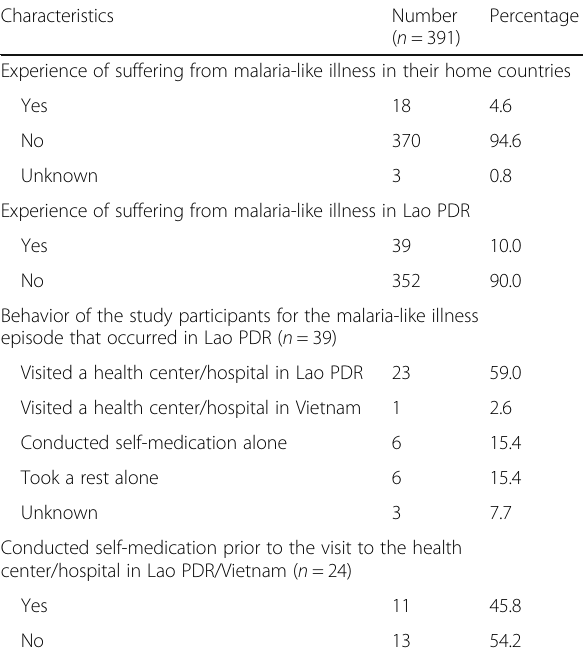
Table 3 Malaria preventive behavior of the study participants Characteristics